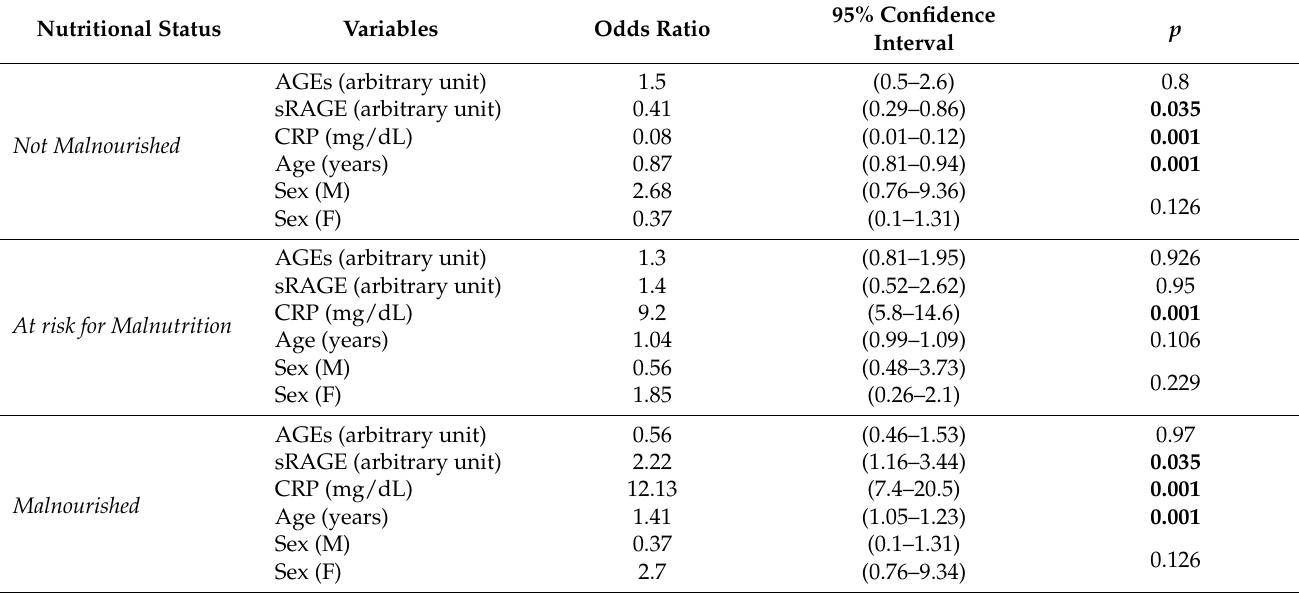
Table 5. Multivariable logistic regression model evaluating the relationship between AGEs, sRAGE and malnutrition